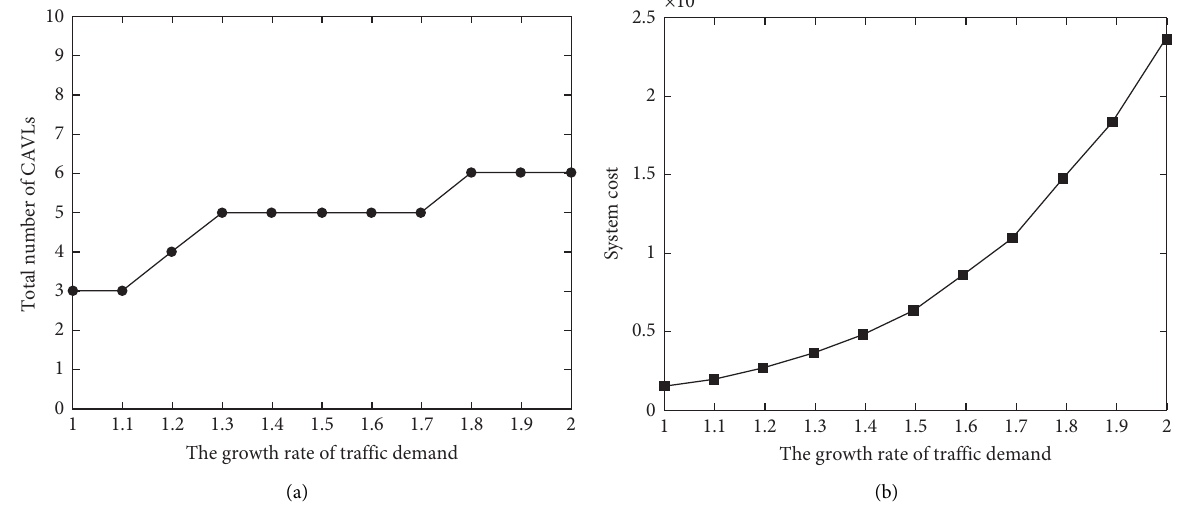
Figure 5: Sensitivity analysis of traffic demand. (a) The total number of CAVLs. (b) System